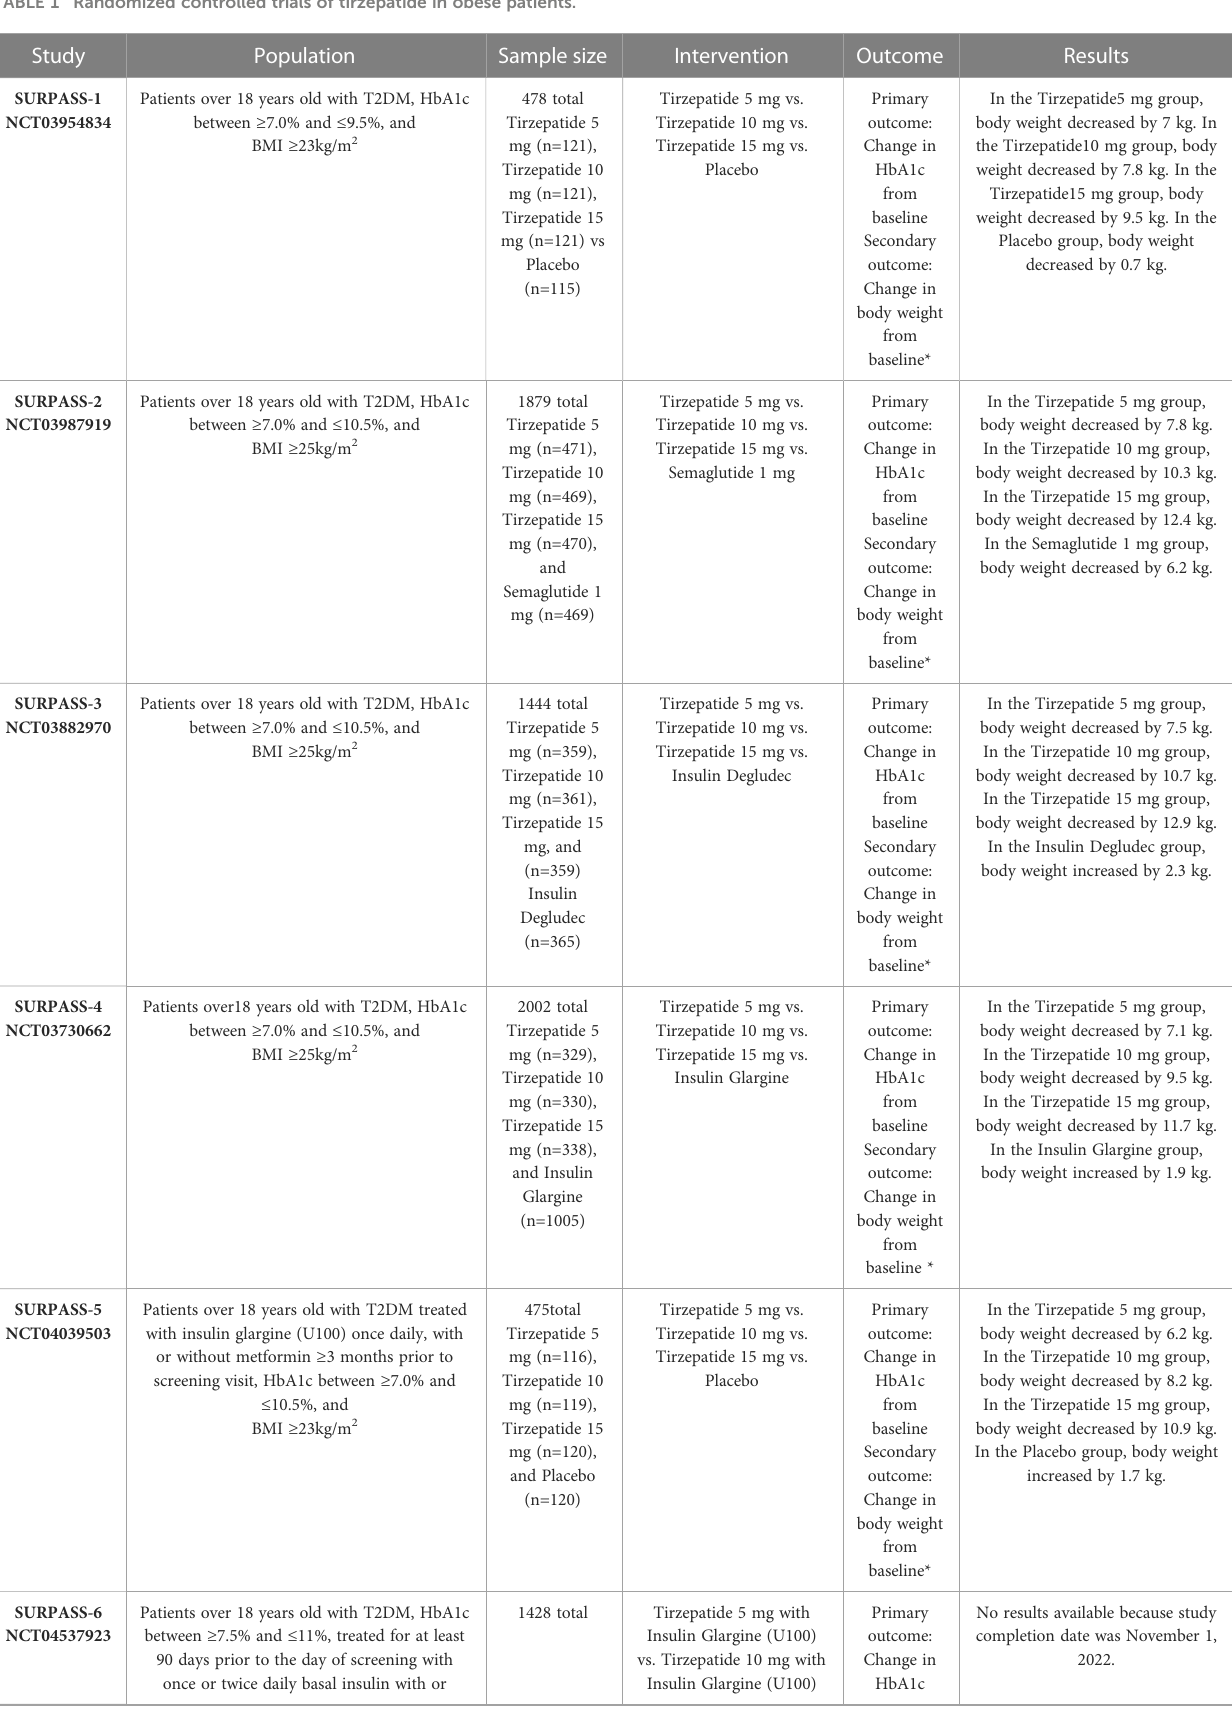
TABLE 1 Randomized controlled trials of tirzepatide in obese